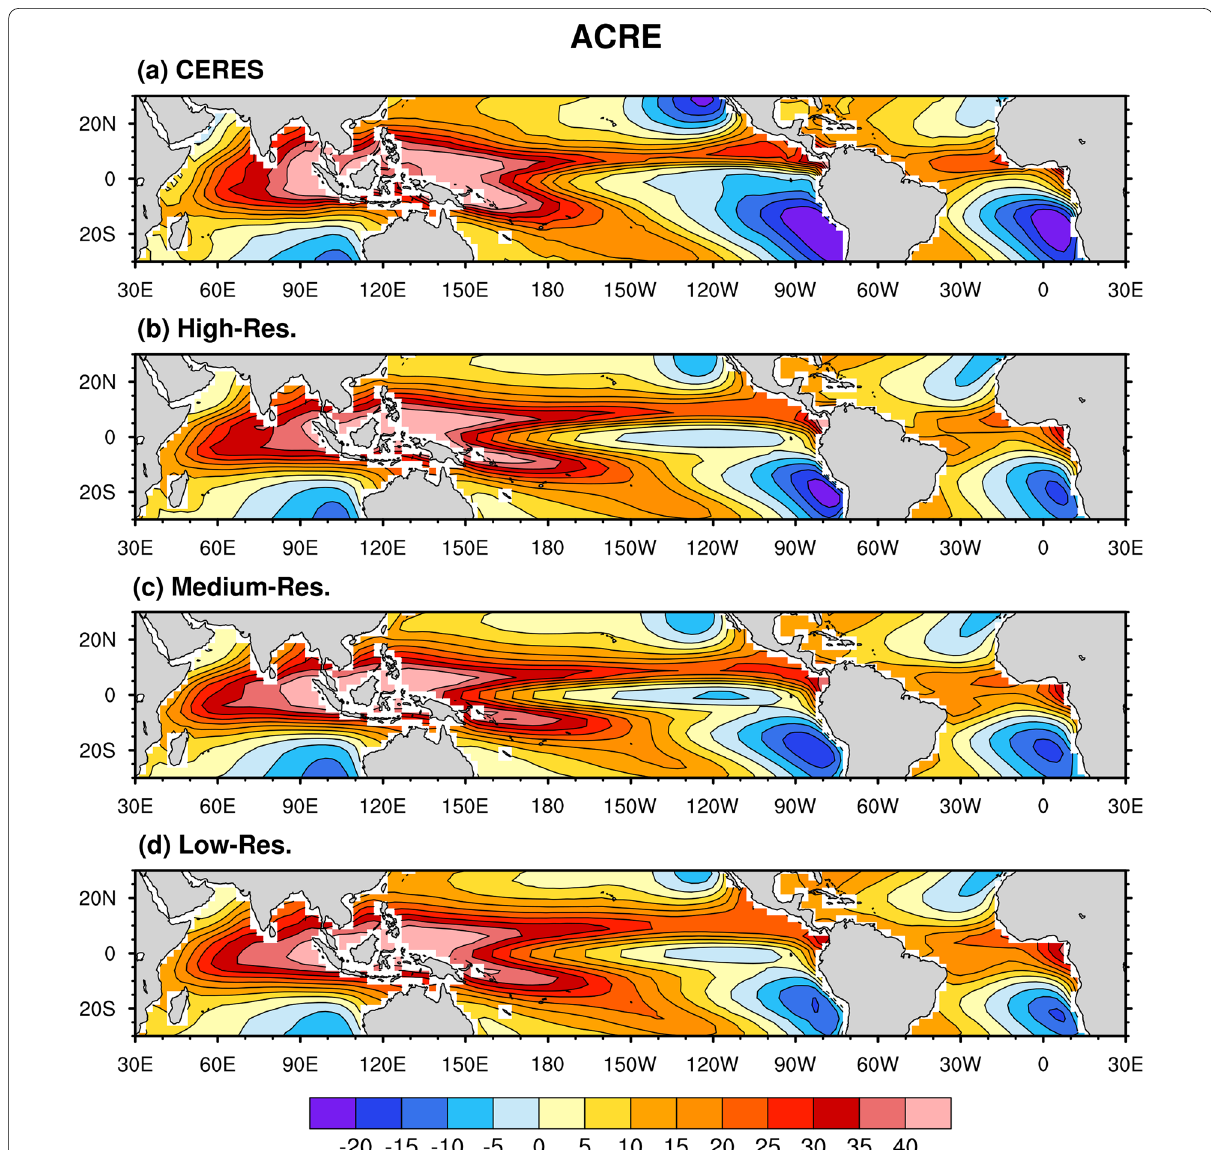
Fig. 4 The spatial pattern of ACRE derived from a CERES‑EBAF, b high‑resolution, c medium‑resolution, and d low‑resolution groups of CMIP6 models. The color (or contour) interval is 5 wattm −